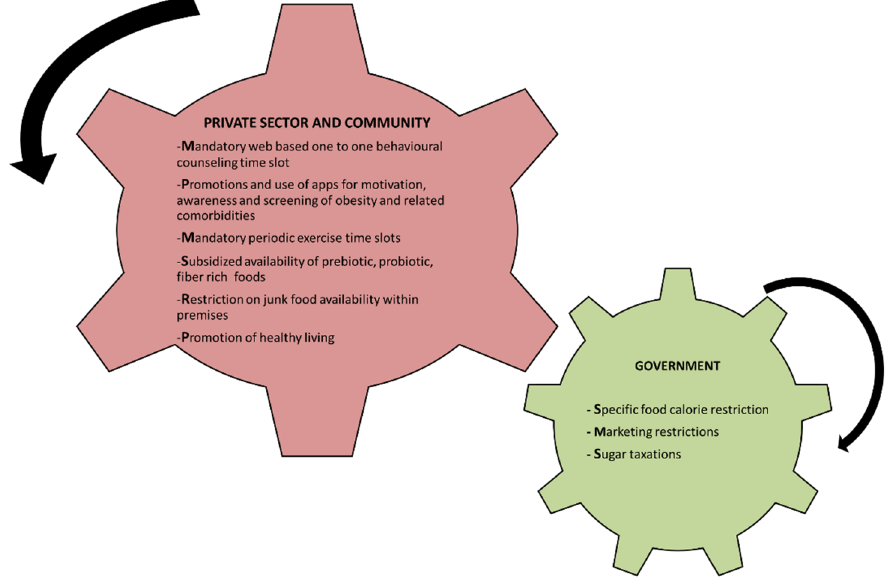
Figure 2. Suggested coordinated interactions between government, community, and the private sector.